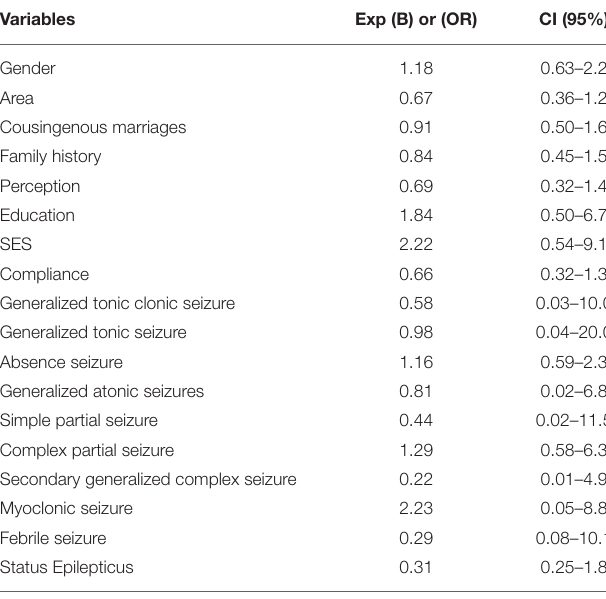
TABLE 3 | Impact of different factors on clinical response of CBZ and VPA